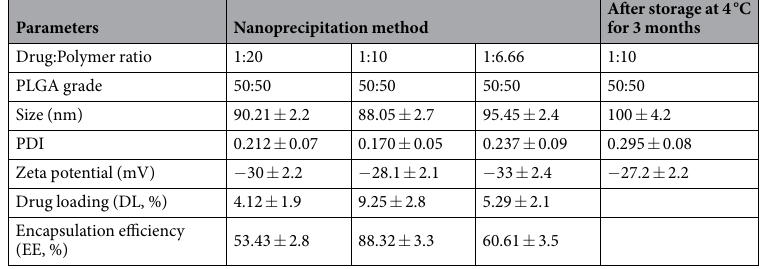
Table1. Characterizaton of